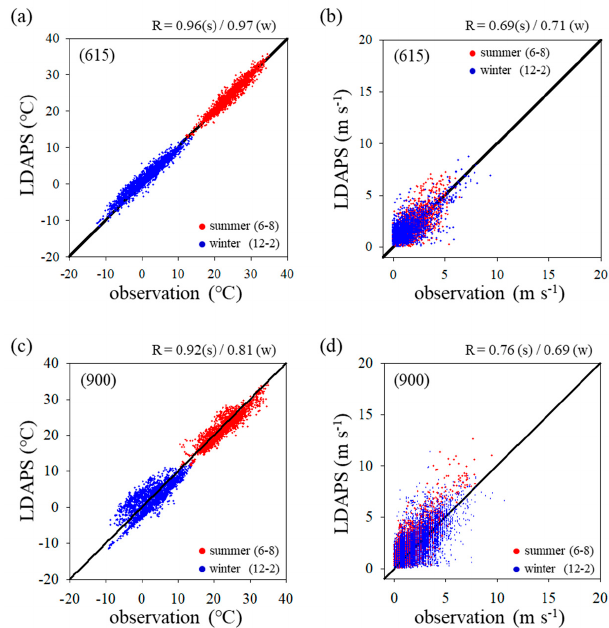
Figure 6. Box plots of the WEs and TEs at the Rf AWSs. The x -axis represents difference between the LDAPS and actual altitudes at the AWSs. Left panel shaded in pink represents the cases that the LDAPS altitudes are lower than the actual altitudes ( ○ A ). Right panel shaded in blue indicates the opposite cases ( ○ B ). Atmosphere 2020 , 11 , x FOR PEER REVIEW